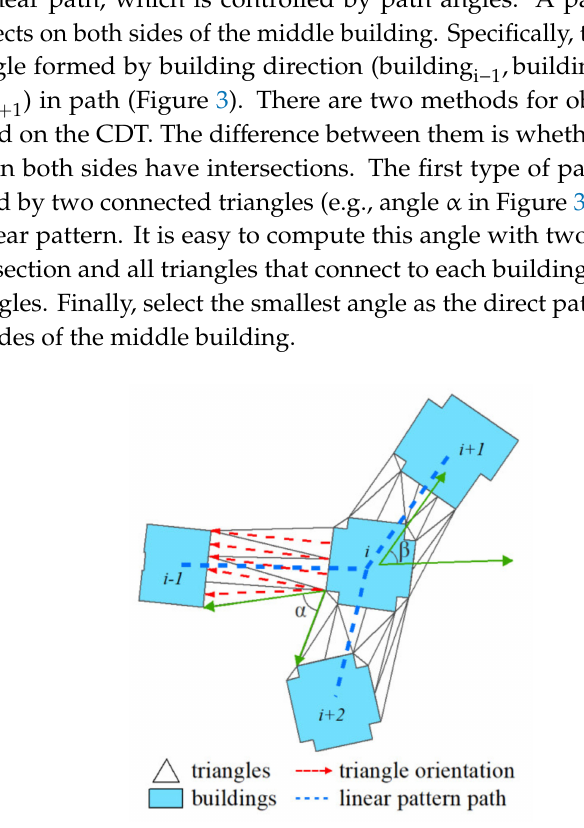
Figure 3. Illustration of the direction between two buildings and the path angle among